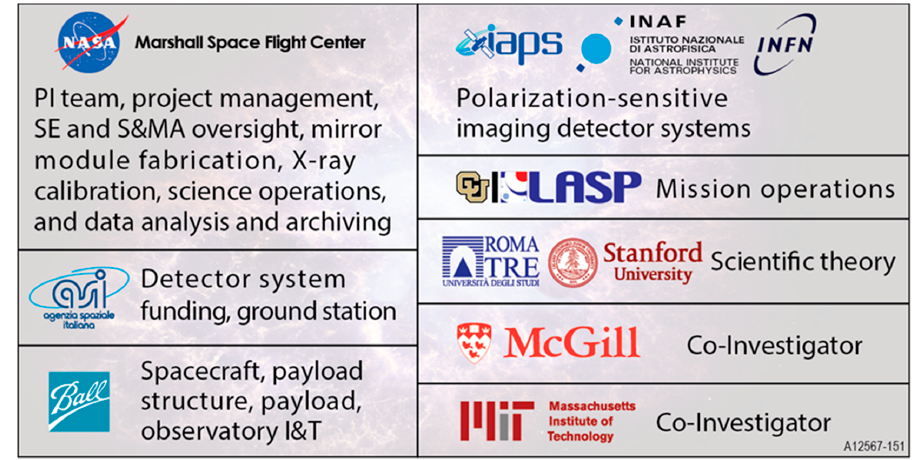
Figure 10. Major institutions involved in IXPE. Abbreviations: PI = principal investigator, SE = systems engineering, S&MA = safety and mission assurance, I&T = integration and test.